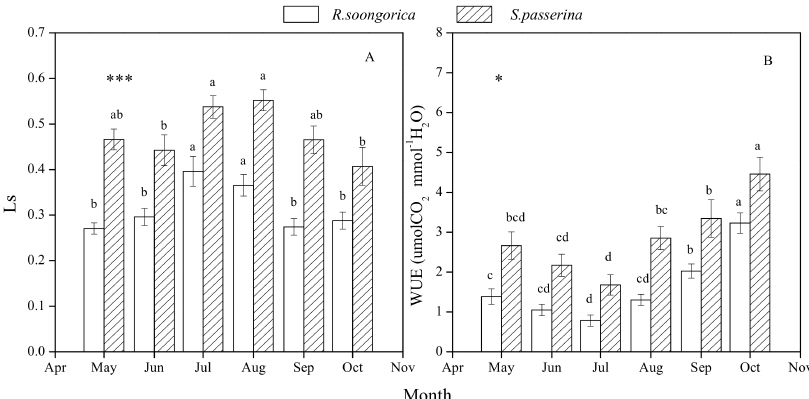
Figure 5. Seasonal changes in stomatal limitation ( A ) and instantaneous water use efficiency ( B ) of R. soongorica and S. passerina. Different lowercase letters indicate significant differences among the months ( p < 0.05). Asterisks indicate significant differences between R. soongorica and S. passerina in stomatal limitation and instantaneous water use efficiency during the experimental period: * p < 0.05; ** p < 0.01; and *** p <